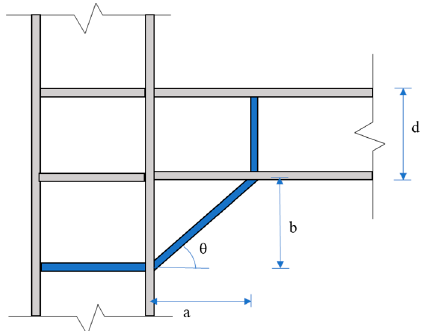
Figure 2. Typical sketch of a haunch connection configuration.